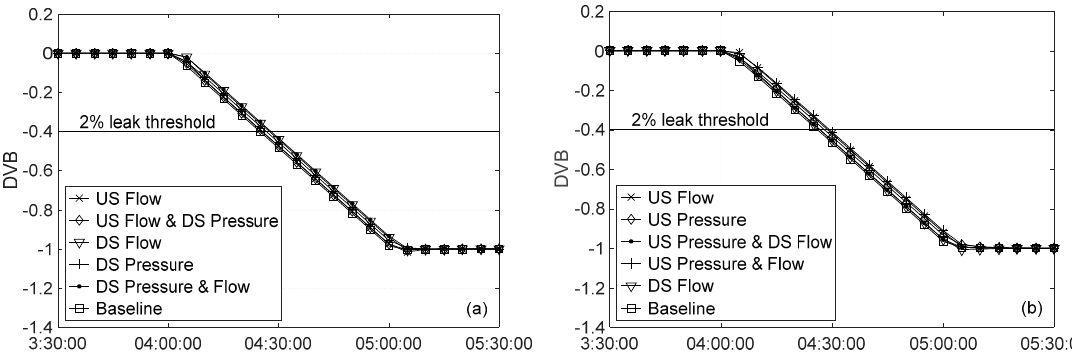
Figure 8. Effect of time skew on leak detectability in a system with R = 2.20 with perfect data (sensors contain a 10-s time skew): ( a ) flow decrease; and ( b ) flow increase.